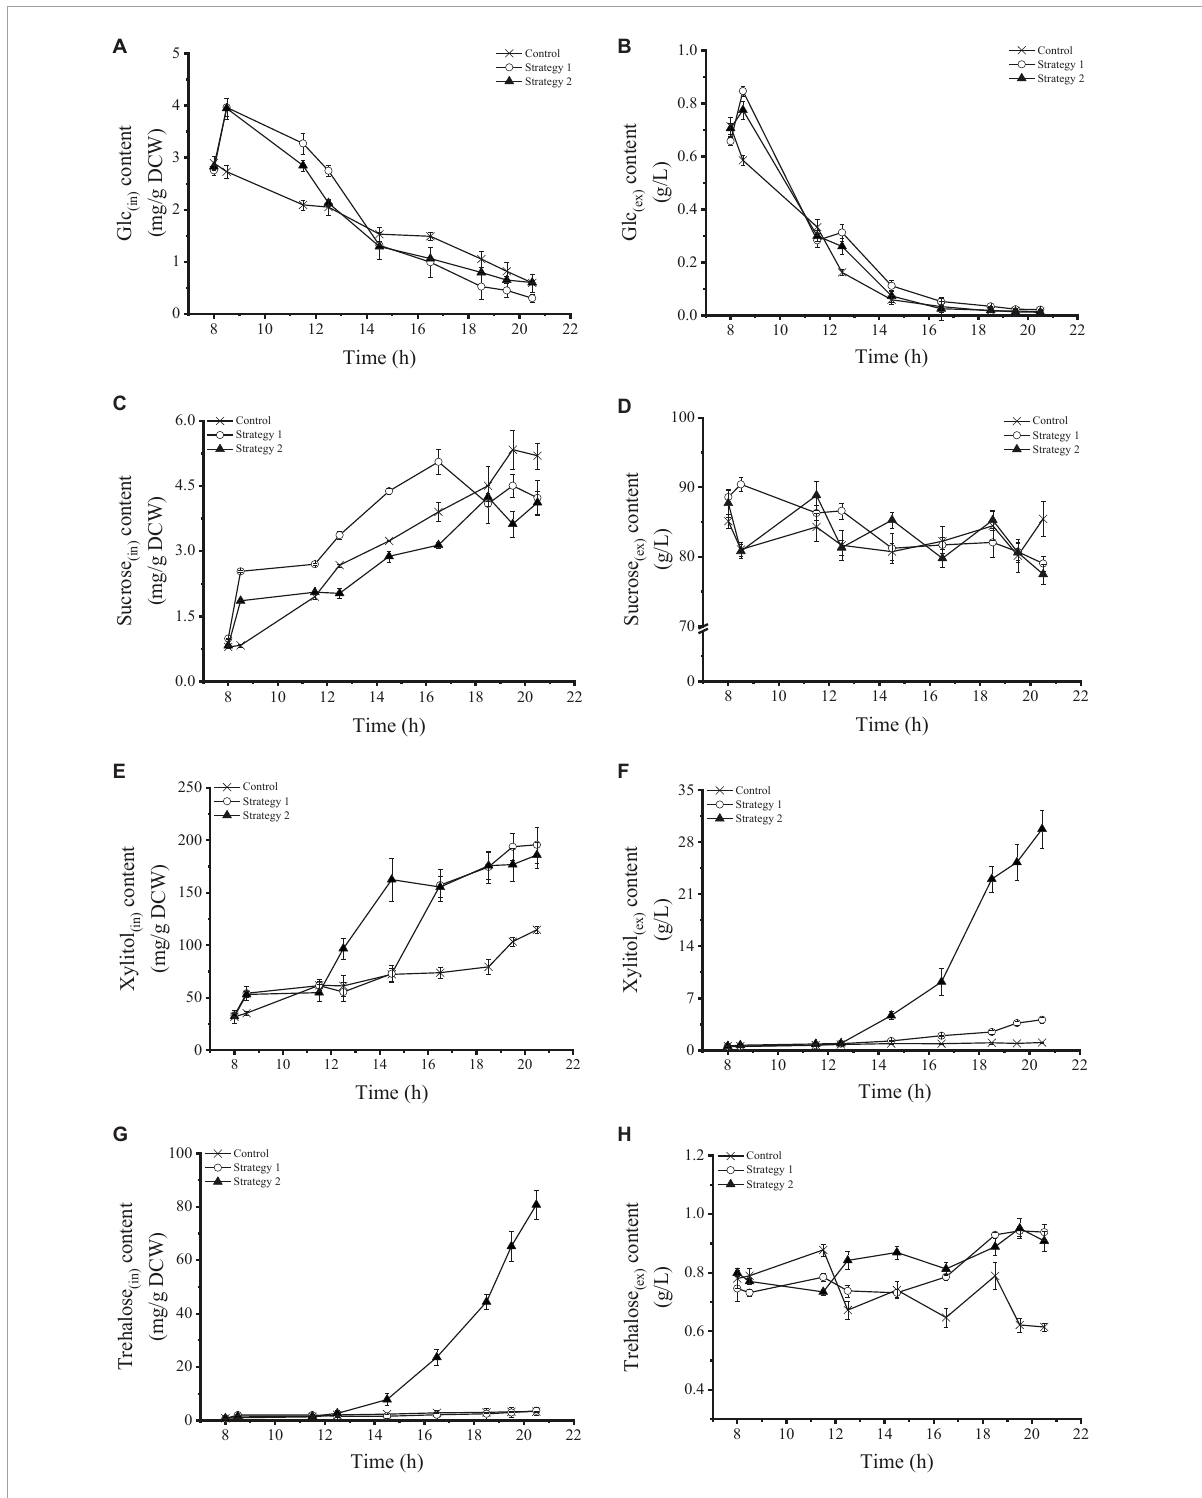
FIGURE2 (A–H) Changes in the intracellular and extracellular carbohydrates content of Z. rouxii using three fermentation regulation strategies. “in” stands for intracellular material, “ex” stands for extracellular